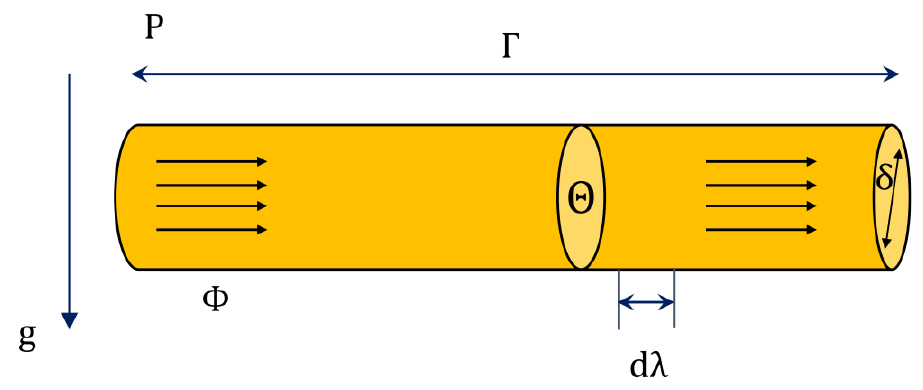
Figure 1. Schematic pipeline.